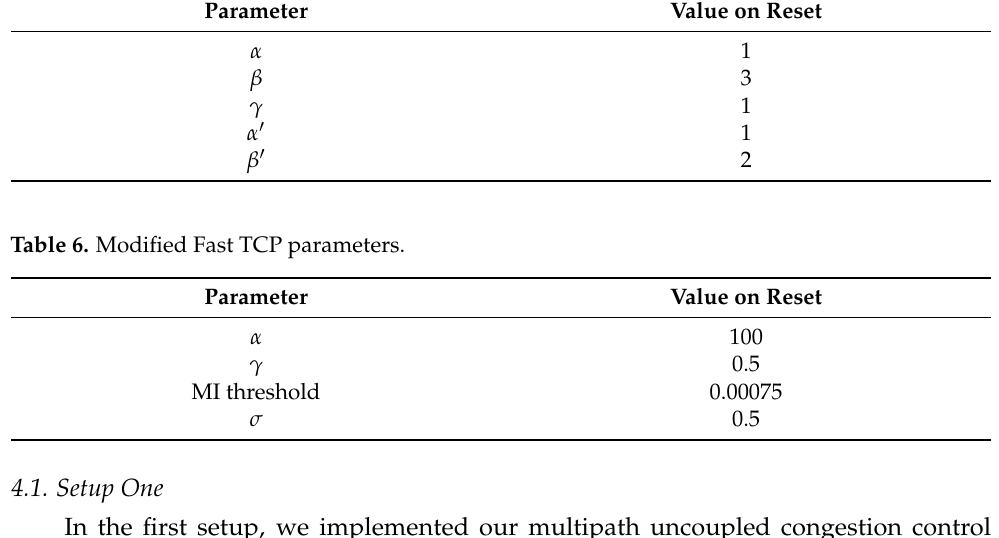
Table 5. Modified TCP Vegas parameters.